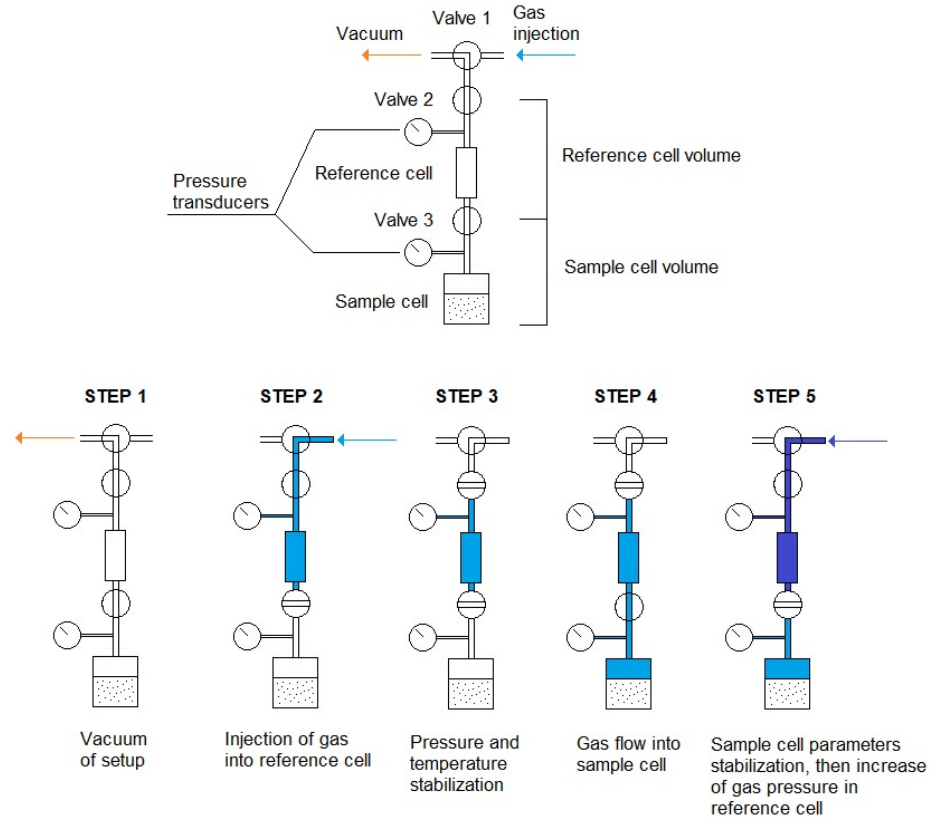
Figure 5. Sorption test procedure.